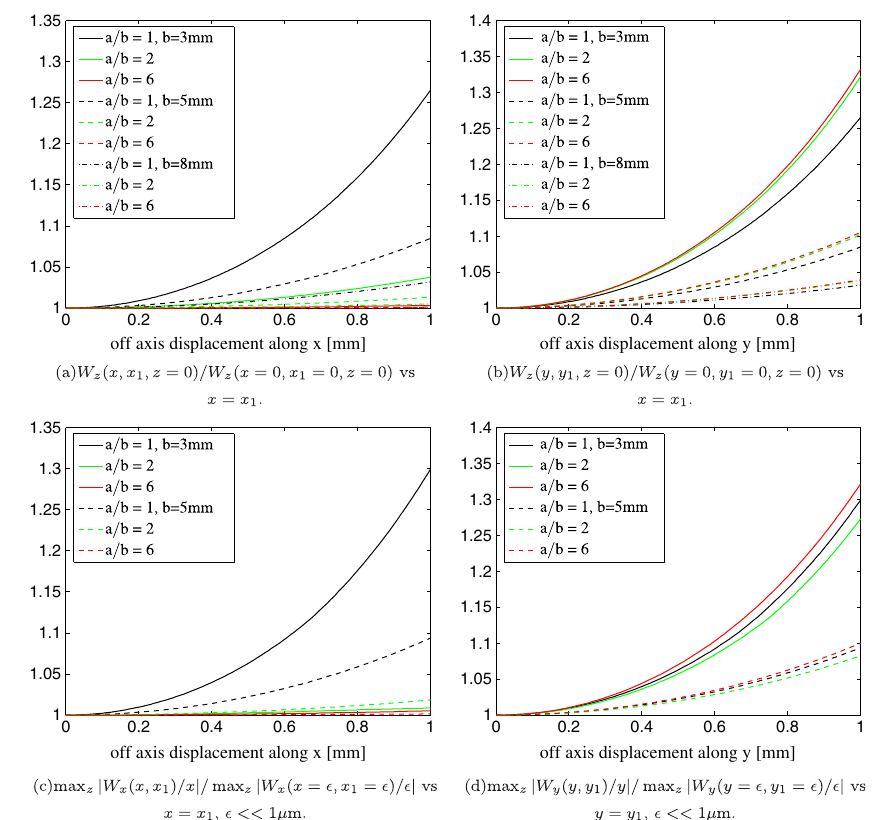
FIG. 3. (Color) Growth of the longitudinal wake functions and nonlinearity with the offset of the transverse wake functions depending on the offset of the leading and trailing charges.